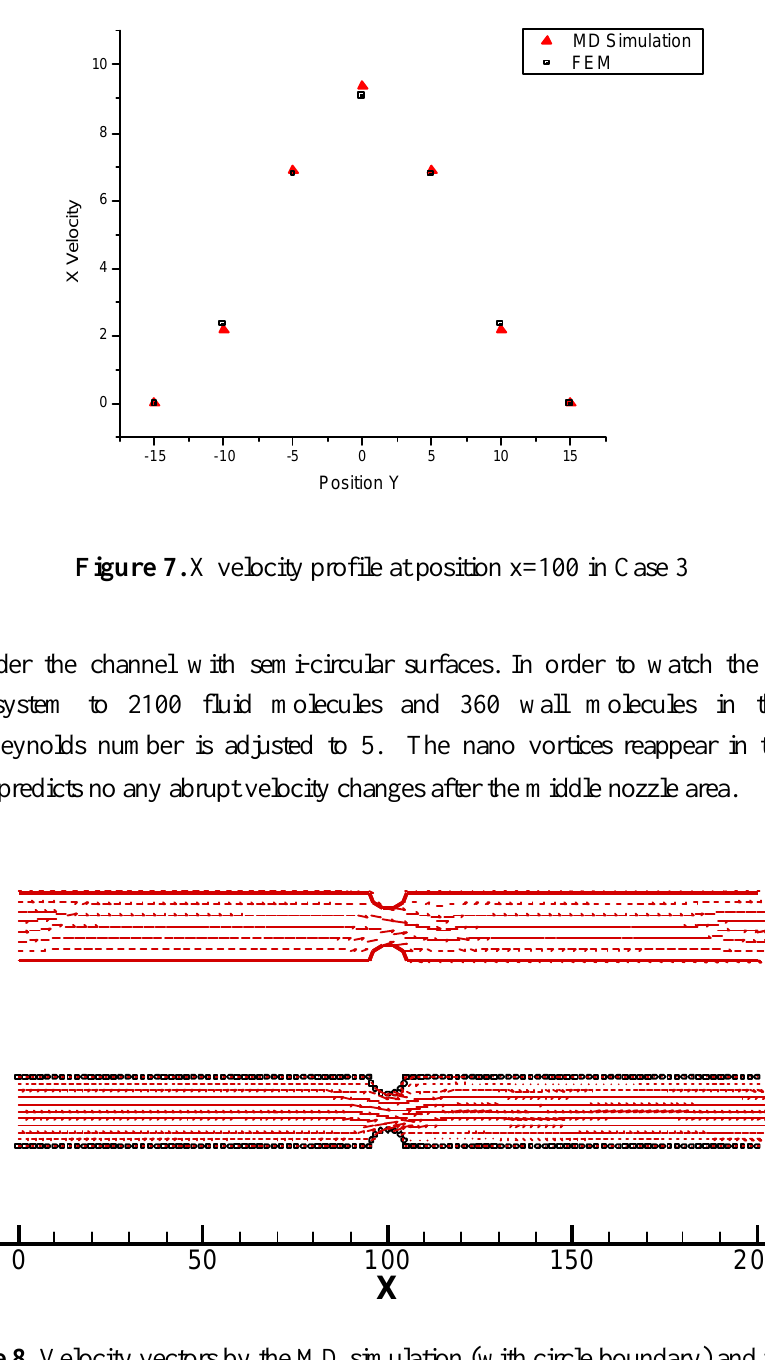
Figure 8. Velocity vectors by the MD simulation (with circle boundary) and the FEM (with solid line boundary) in Case